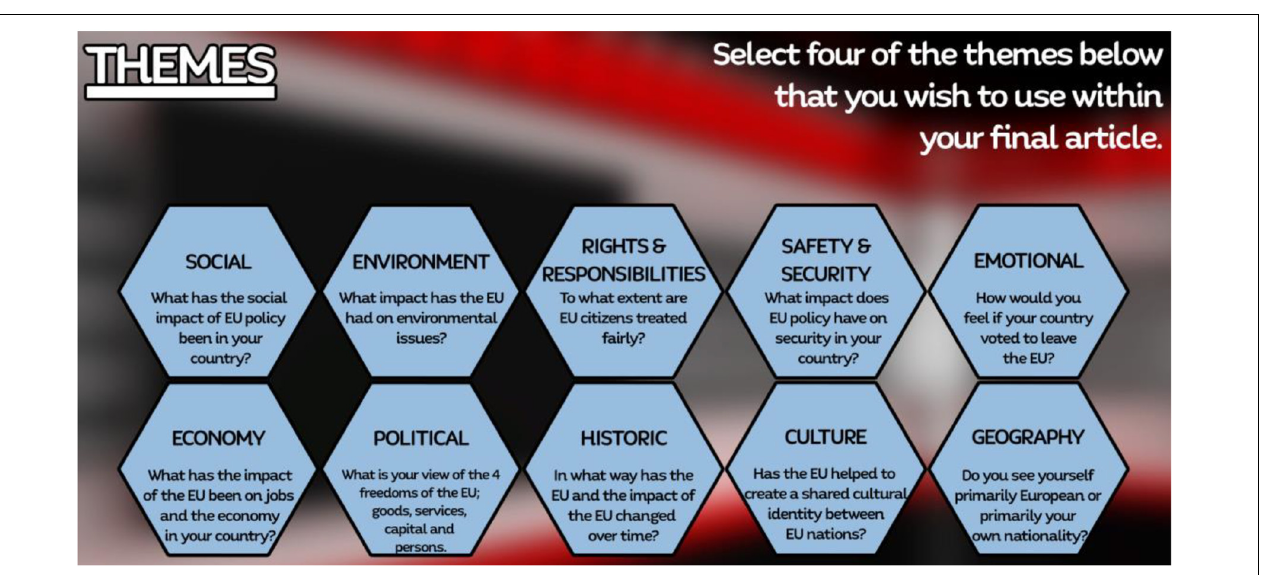
FIGURE 2 | Game themes of European